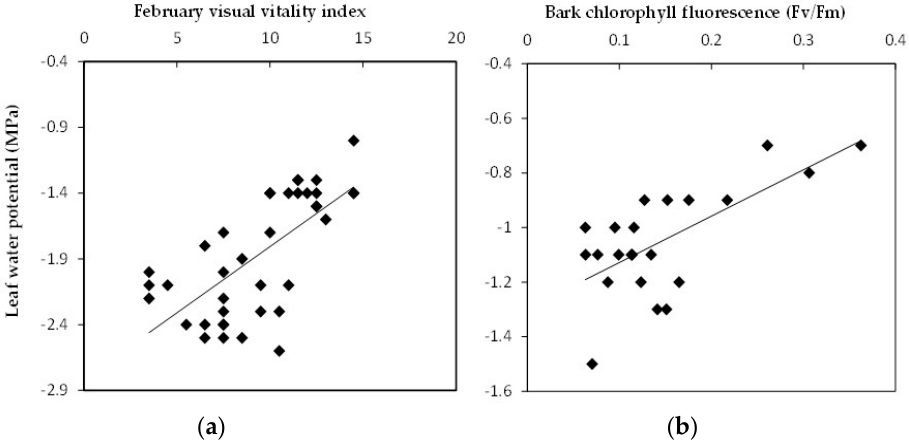
Figure 2. ( a ) Ulmus spp. midday leaf water potential (MPa) versus February Urban Visual Vitality Index ( p < 0.000, r 2 = 0.462, n = 38); ( b ) Ulmus spp. pre-dawn leaf water potential (MPa) versus branch bark chlorophyll fluorescence (F v /F m ) and ( p < 0.001, r 2 = 0.454, n = 22).